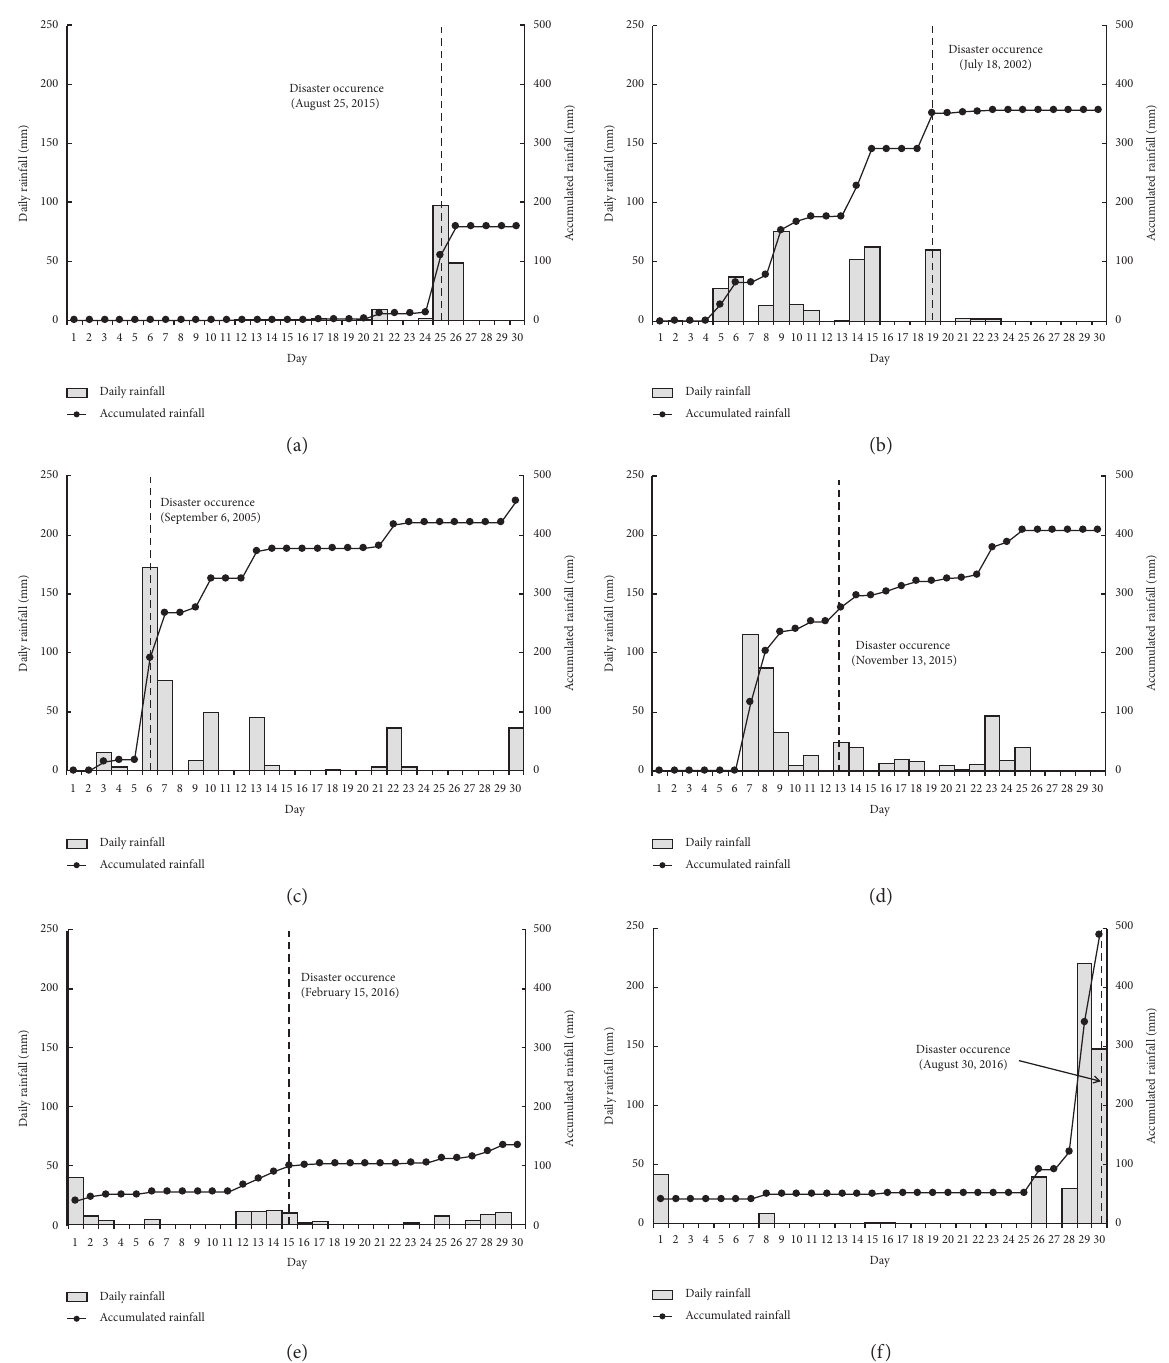
Figure 3: Analysis of the changing pattern for daily and accumulated rainfall before and after the date of disaster occurrence. (a) August 2015. (b) July 2002. (c) September 2005. (d) November 2015. (e) February 2016. (f) August